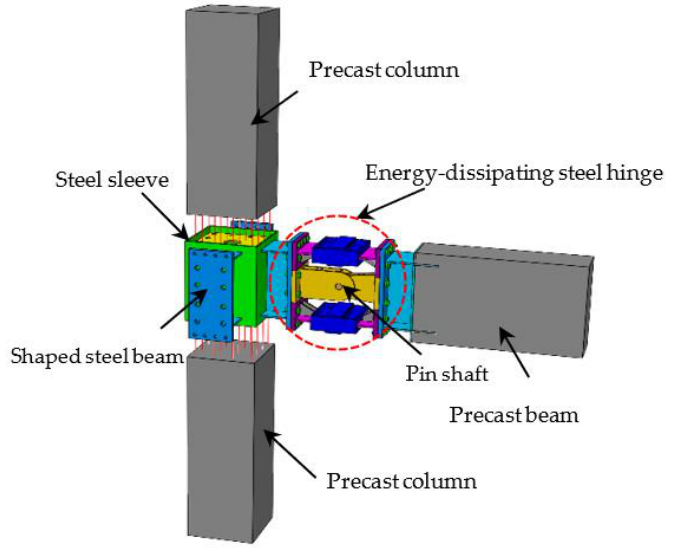
Figure 1. Precast replaceable beam-to-column joint with an energy-dissipating steel